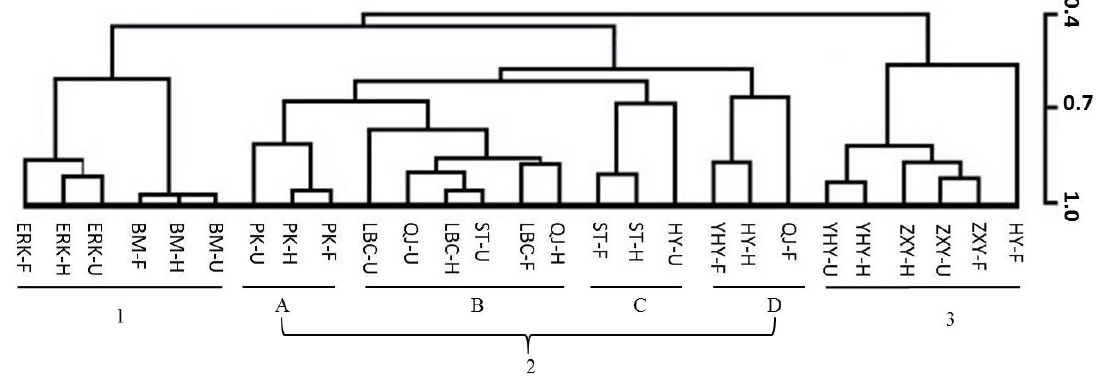
Figure 5. Hierarchical cluster analysis based on flower volatiles during blooming for nine cultivars (abbreviated names of cultivars are as in Table 1, and 1 to 3 represent different cluster groups; while U represents unopened; H: half opened and F: fully opened flower blooming stages). Group 1 represented the citron, group 2 comprised four subgroups (2 A Ponkan, 2 B sweet orange and Satsuma mandarin, and 2 C Satsuma mandarin and Huyou, and 2 D Yuhuanyou, Huyou and Qingjia), while group 3 represented pomelo and